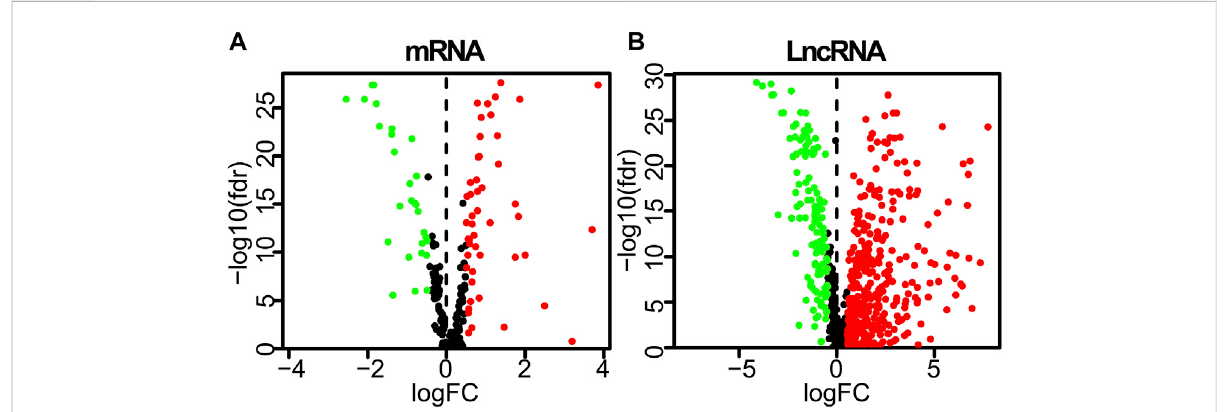
FIGURE 2 Differently expressed autophagy-related genes and lncRNAs based on the correlation coef fi cient | log2(FC)| ≥ 0.5 and adjusted p < 0.05. (A) Volcano plot of differently expressed autophagy-related genes. (B) Volcano plot of differently expressed lncRNAs between LUAD tumor and normal samples. FC, fold change.